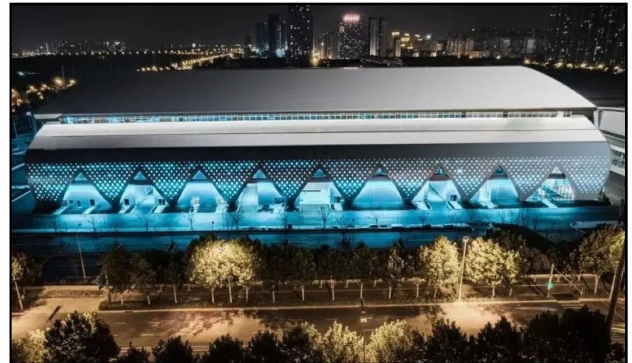
Figure 5. Bird’s-eye view of Hefei Binhu International Convention and Exhibition Center Phase II Project (images from WeChat link: https://mp.weixin.qq.com/s/b71zVnDkGa5nr-kWHPBBnQ, accessed on 20 February 2023).